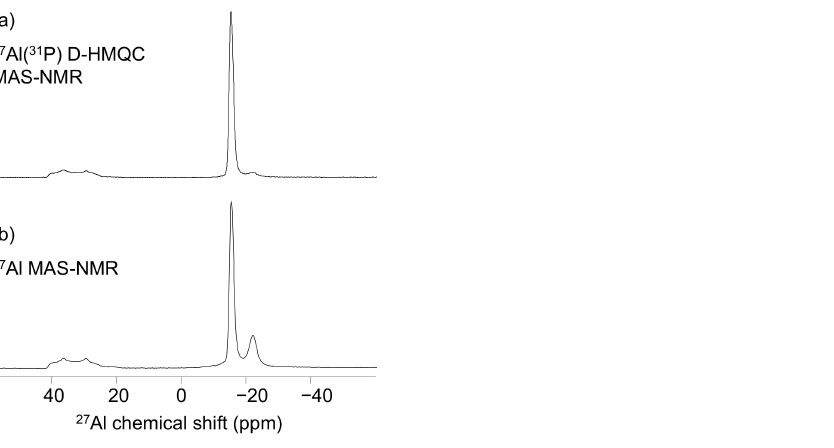
Figure 5. 1D 27Al(31P) D-HMQC ( a ) and 27Al ( b ) MAS-NMR spectra obtained at 500 ◦ C on the P/Al = 3 solution with 10 ◦